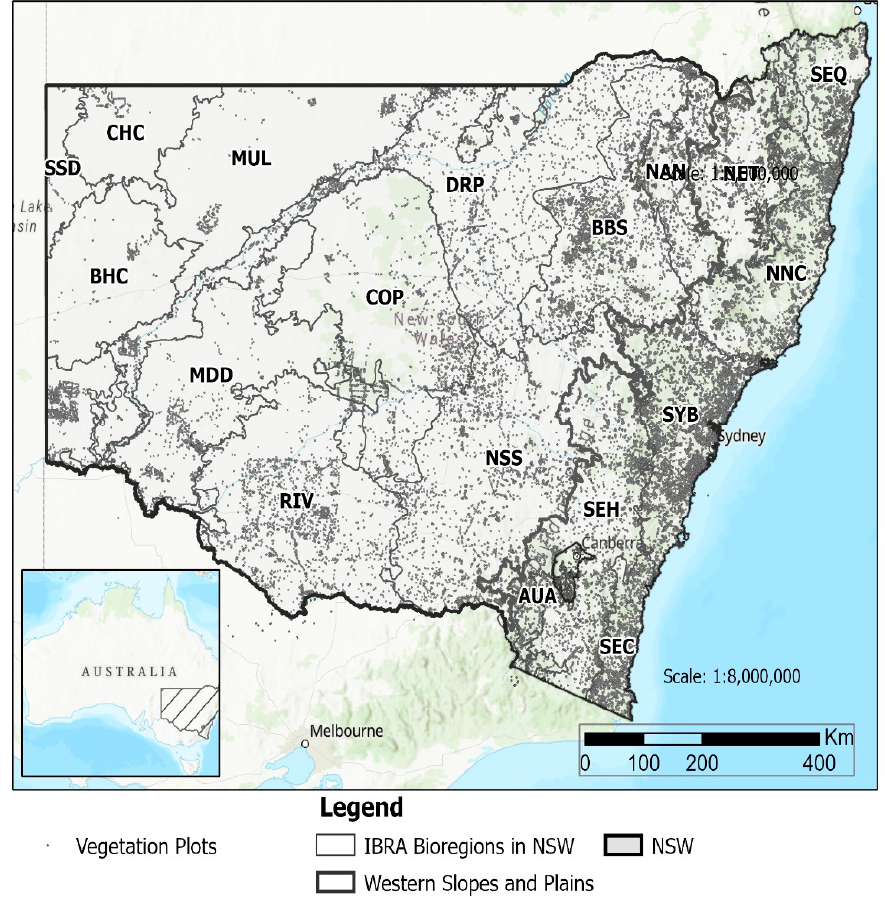
Figure 2. Distribution of floristic plot data (dots) in 18 IBRA bioregions [14] in NSW. Plot data are patchy across most of inland NSW that comprises 11 bioregions: NSS, NAN, BBS, DRP, RI, COP, MUL, MDD, BHC, CHC and SSD.